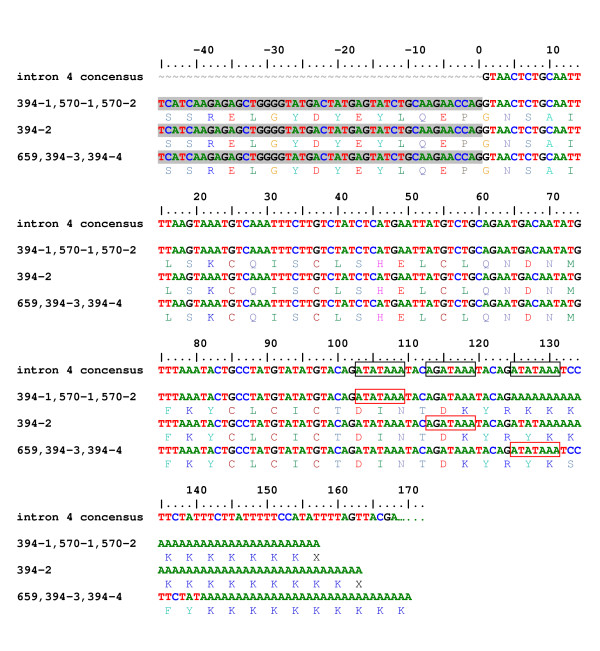
Nucleotide and deduced amino acid sequences of 7 major transcripts belonging to 3 types of recessive white chickens that were isolated by RACE and compared with the published Tyrosinase cDNA sequence. All of these 7 transcripts had normal exon 1 to exon 4 sequences but lacked the exon 5 sequence. A short sequence (from 124 bp to 140 bp) of intron 4 replaced the exon 5 sequence followed by a polyA tail. The exon 4 sequence is shown in grey color. Three putative polyadenylation signals ATATAAA, AGATAAA and ATATAAA in the intron 4 sequence are shown in boxes. For each transcript, the proposed polyadenylation signal is shown in the red box. The predicted amino acid sequence is shown below the nucleotide sequence.